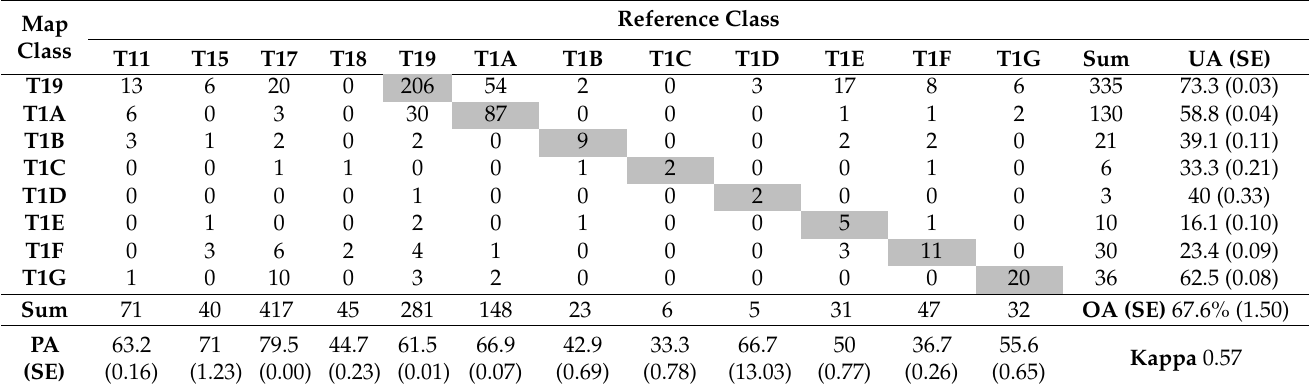
Table 6. Confusion matrix of RF result for the broadleaved evergreen forest habitat type EUNIS III level classification. T21: mediterranean evergreen Quercus forest, T22: mainland